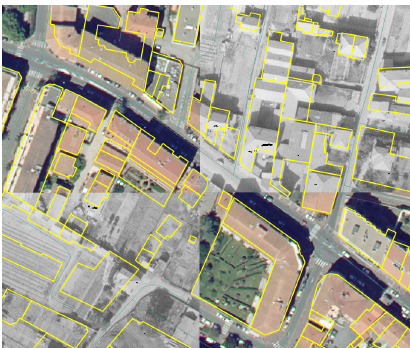
Figure 7. Fabas 1942. ”Fine absolute” 1942 orthoimage superimposed with the current orthoimage and a recent buildings and roads vector database (yellow).